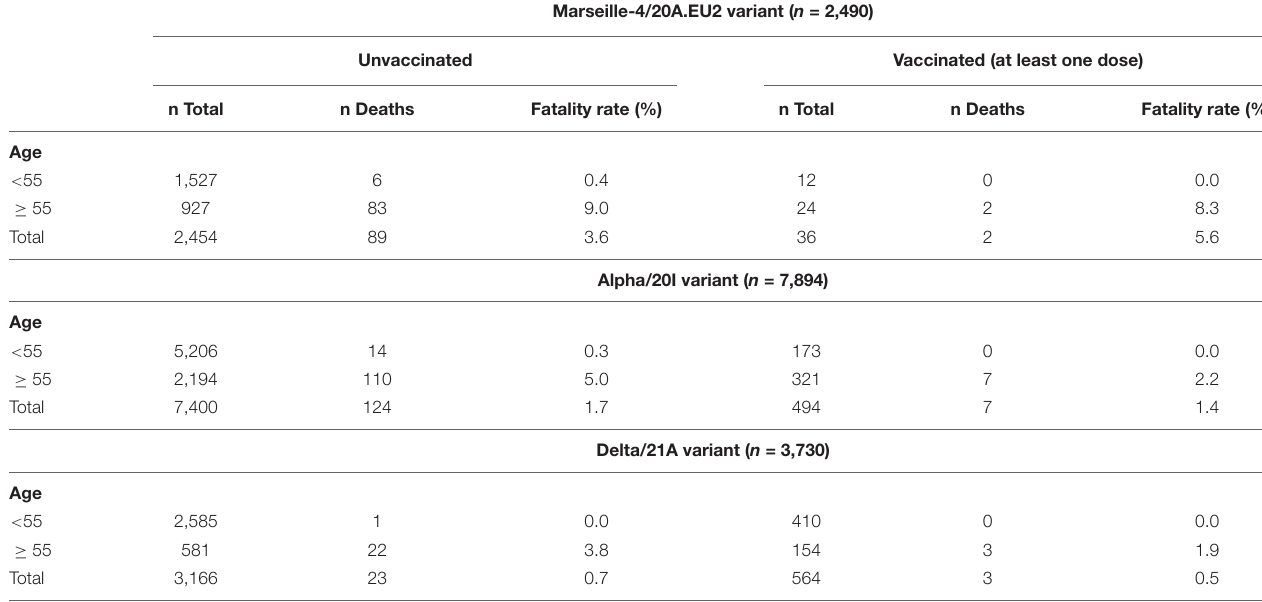
TABLE 2 | Fatality rate according to SARS-CoV-2 variant, age and vaccinal status ( n = 14,114*).